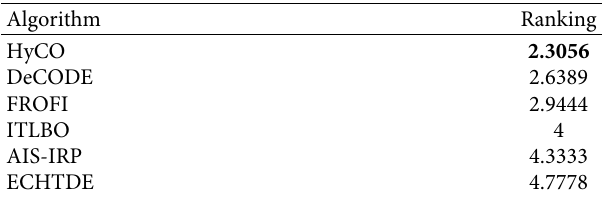
Table 6: Rankings obtained by the Friedman’s test for HyCO and other compared algorithms on 18 COPs with 30d from CEC 2010.